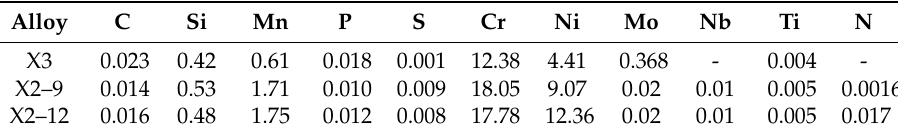
Table 1. Chemical composition (in (wt. %)) of the tested